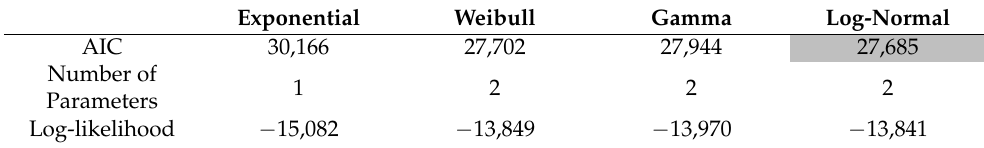
Table 6. AIC values for possible distributions of equalization reserves (reinsurer). Exponential Weibull Gamma Log-Normal AIC 30,166 27,702 27,944 27,685 Number of 1 2 2 2 Parameters Log-likelihood − 15,082 − 13,849 − 13,970 −